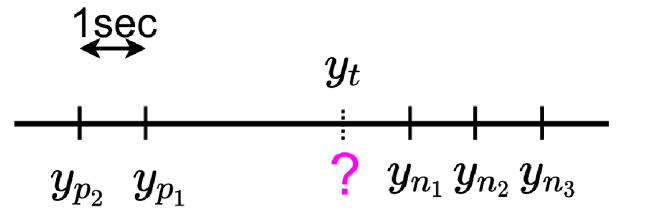
Fig 7. Chronological data imputation.